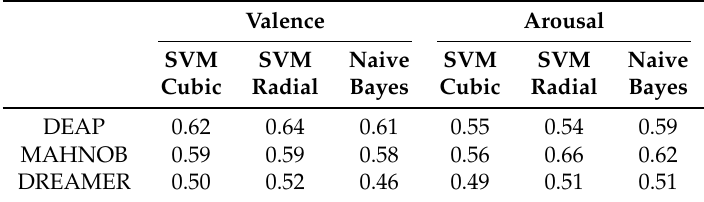
Table 5. Results when using an intra-subject model, in the three databases.